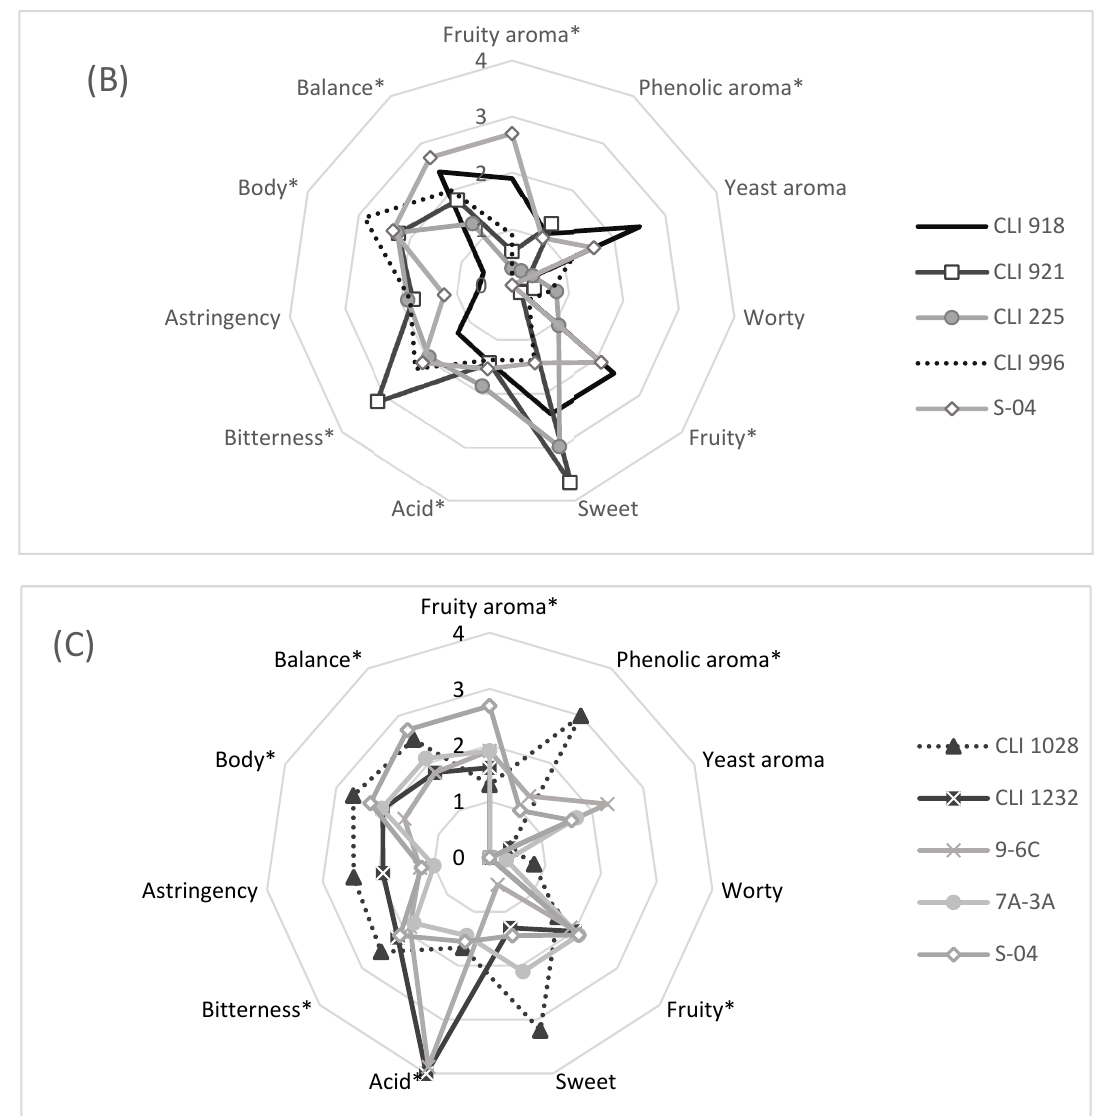
Figure 5. Sensory analysis of the 13 beers studied. Aroma attributes: fruity aroma, phenolic aroma, yeast aroma; flavour attributes: worty, fruity, sweet, acid, bitter; overall attributes: astringency, body, balance. * Significantly different (ANOVA; p < 0.05). ( A ) sensory analysis for strains CLI 3, CLI 190, CLI 457, CLI 650, S-04; ( B ) CLI 918, CLI 921, CLI 225, CLI 996, S-04; ( C ) sensory analysis for strains CLI 1028, CLI 1232, 9-6C, 7A-3A y S-04.